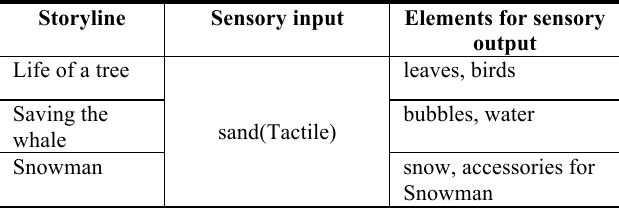
Table 4. Different storylines in Sandtime